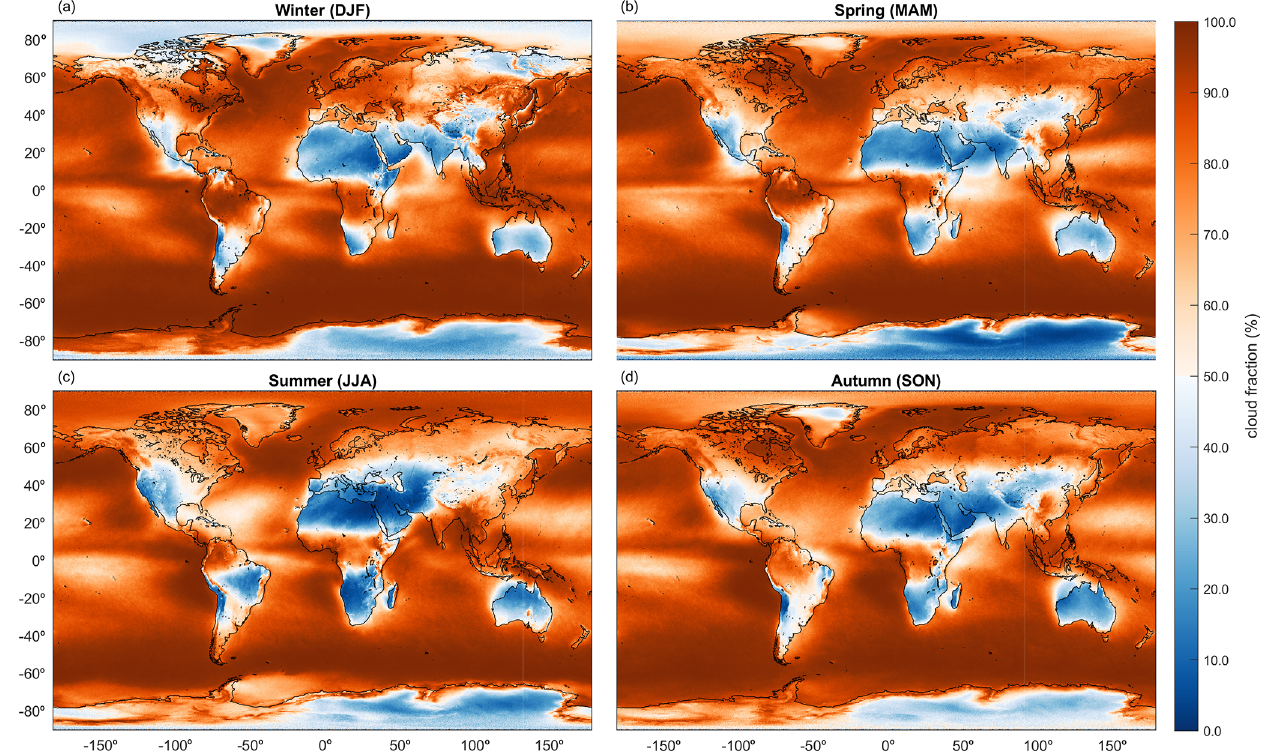
Figure 4. Seasonal mean daytime cloud cover (%) calculated from the IASI neural network cloud detection algorithm between 2008 and 2020. (a) Winter (December–February), (b) spring (March–May), (c) summer (June–August), (d) autumn